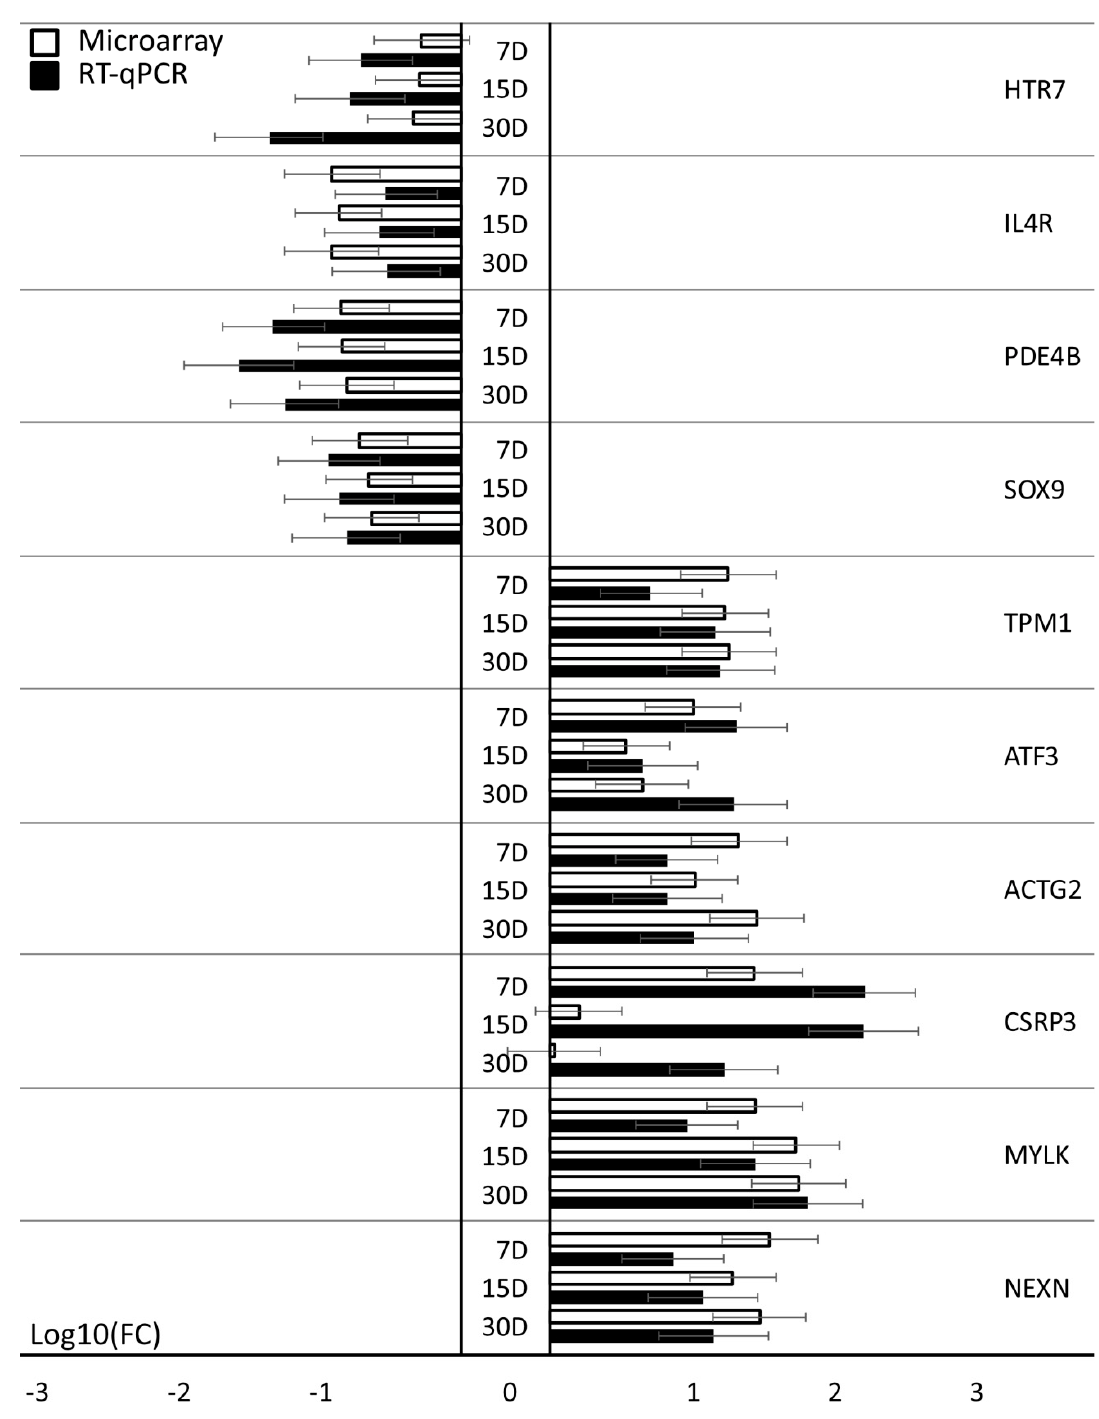
Figure 4. Microarray validation: RT-qPCR. The RT-qPCR results described validation of microarrays gene expression (log (FC)). Error bars represent the standard error mean (SEM; n = 3). All of the presented sample means were deemed to be statistically significant ( p < 0.05). D: day of culture; FC: fold change.